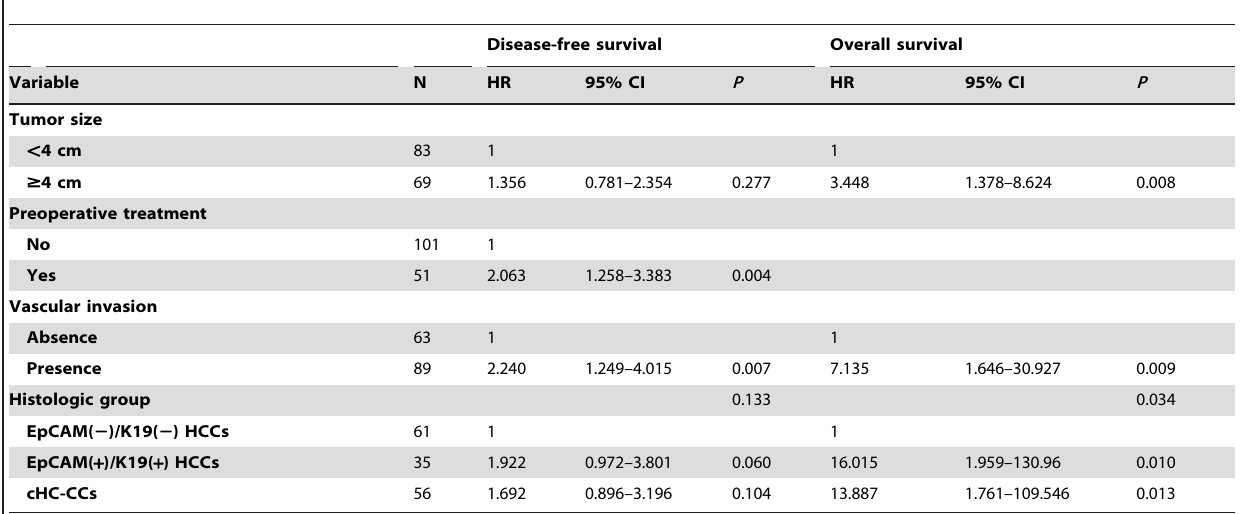
Table 5. Independent prognostic factors for disease-free and overall survival by multivariable